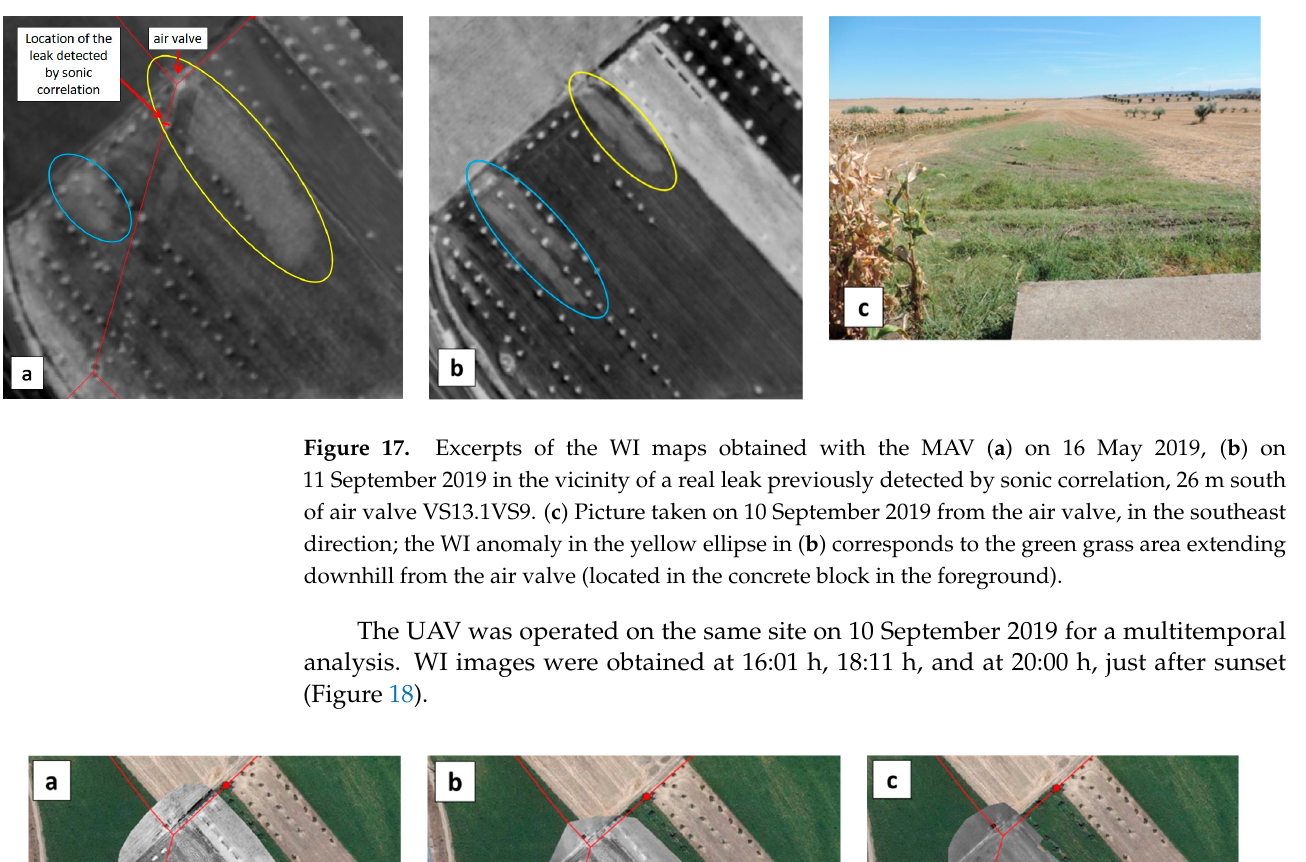
20 of 31 Figure 16. Correlation between the local Water Index inferred from the multispectral images ob ‐ tained with the UAV and the soil moisture measured with a TDR probe at distances ranging from 0 to 30 m from the artificial leaks at hydrants H10, H11 and H5.6 (Figures 11–14 and 15a). The acoustic campaign in Monte Novo located another leak by sonic correlation at 26 m from an air valve. Close to it, the WI image showed a significant contrast over an elongated area starting from the air valve and extending downhill in the southeast di ‐ rection (yellow ellipse in Figure 17a). A similar pattern, yet shorter, was observed in the same field (blue ellipse in Figure 17a). During the next flight on 11 September 2019, the first pattern shrunk whereas the second one appeared more elongated (Figure 17b). The